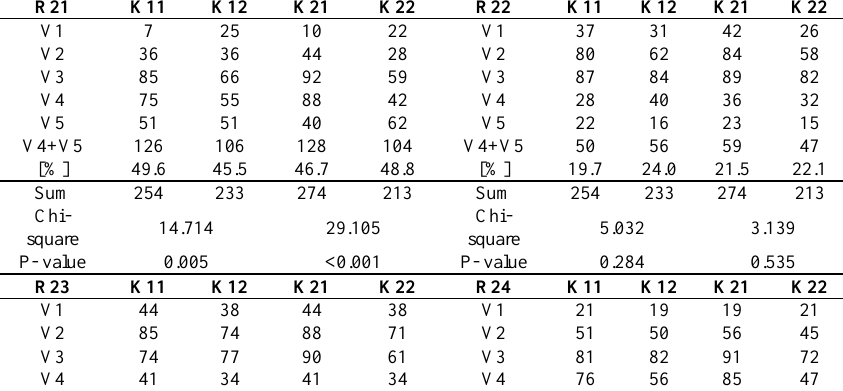
Table 2. The evaluation of sources of economic risk by